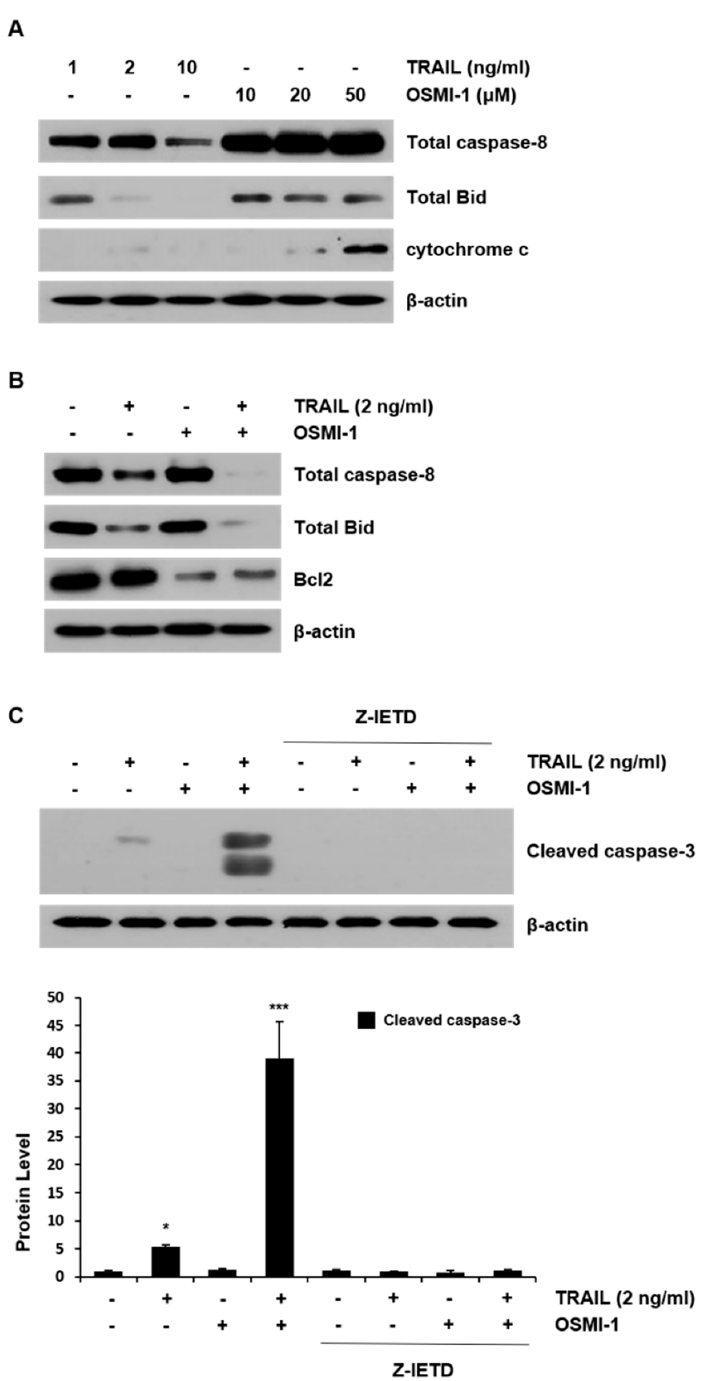
Figure 2. OSMI-1 enhances TRAIL-induced apoptosis in HCT116 cells. ( A ) HCT116 cells were treated with TRAIL (1, 2 and 10 ng/mL) or OSMI-1 (10, 20 and 50 μ M) for 24 h. Whole-cell extracts were then prepared and the levels of caspase-8, Bid and cytochrome c were determined by western blot analysis. ( B ) Total cell lysates were collected from HCT116 cells treated with 2 ng/mL TRAIL or 20 μ M OSMI-1 alone or in combination for 24 h. Caspase-8, Bid and Bcl2 levels were measured by western blot analysis. Actin was used as a loading control for each lane. ( C ) Cells treated with TRAIL and/or OSMI-1 or in combination with or without 10 μ M Z-IETD-FMK were analyzed using western blot analysis. Data are expressed as the mean ± SEM for 3–4 independent experiments; * p < 0.05, *** p < 0.005 vs. control.